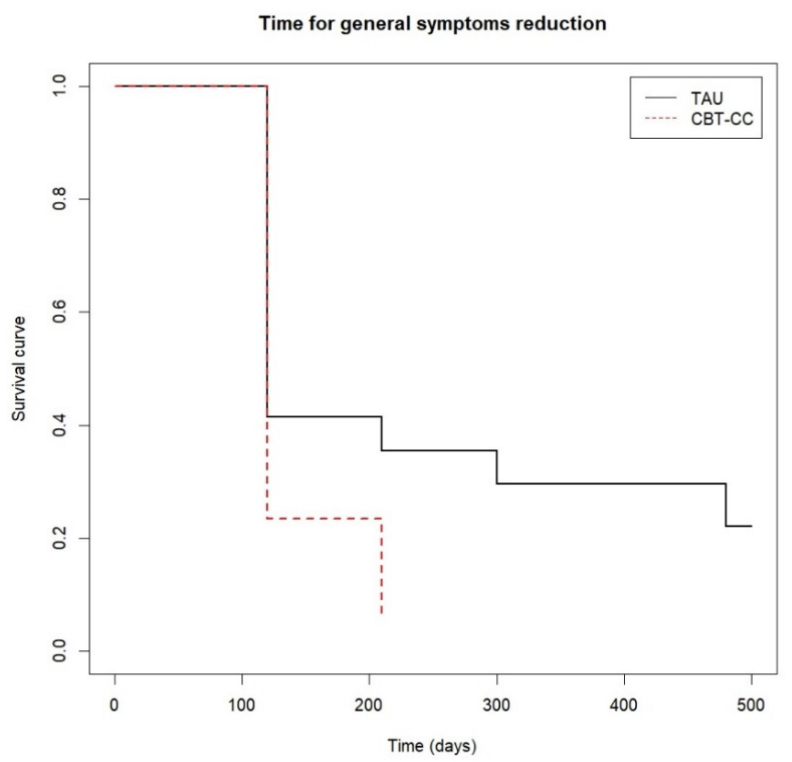
Figure 4. Time to general psychotic symptoms reduction.